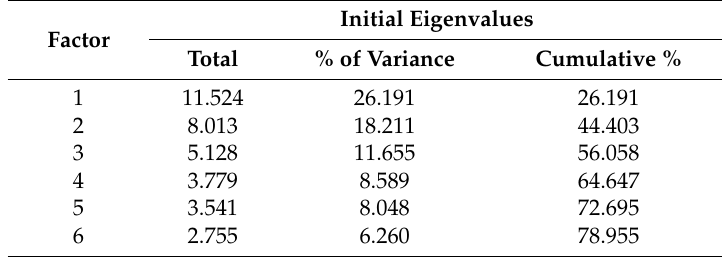
Table 1. Results of common method variance analysis.